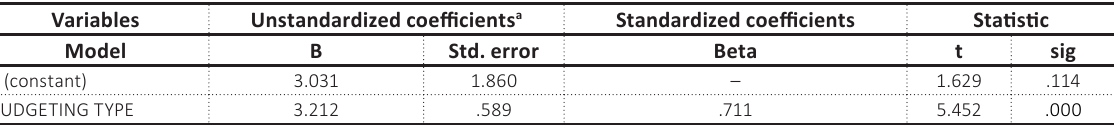
Table 4. Regression